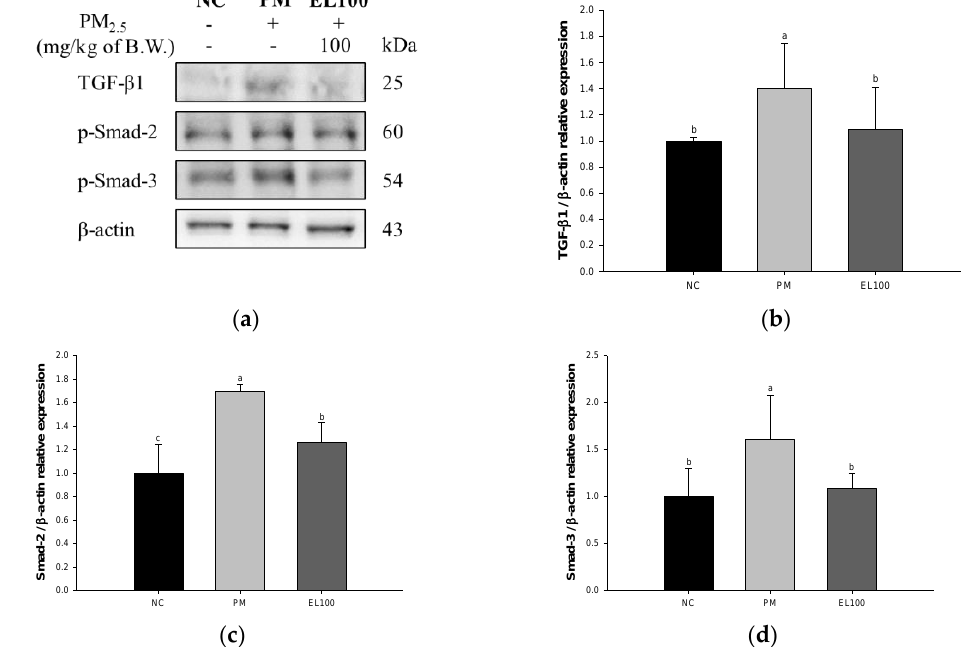
in Figure 8. Transforming growth factor beta (TGF-β1) (139.93%), phosphorylated small mothers against decapentaplegic (p-Smad)-2 (169.55%), and p-Smad-3 (160.48%) expres- sion levels in the PM group were significantly upregulated compared to the NC group (100%). However, the EL100 group statistically downregulated TGF-β1 (108.49%), p-